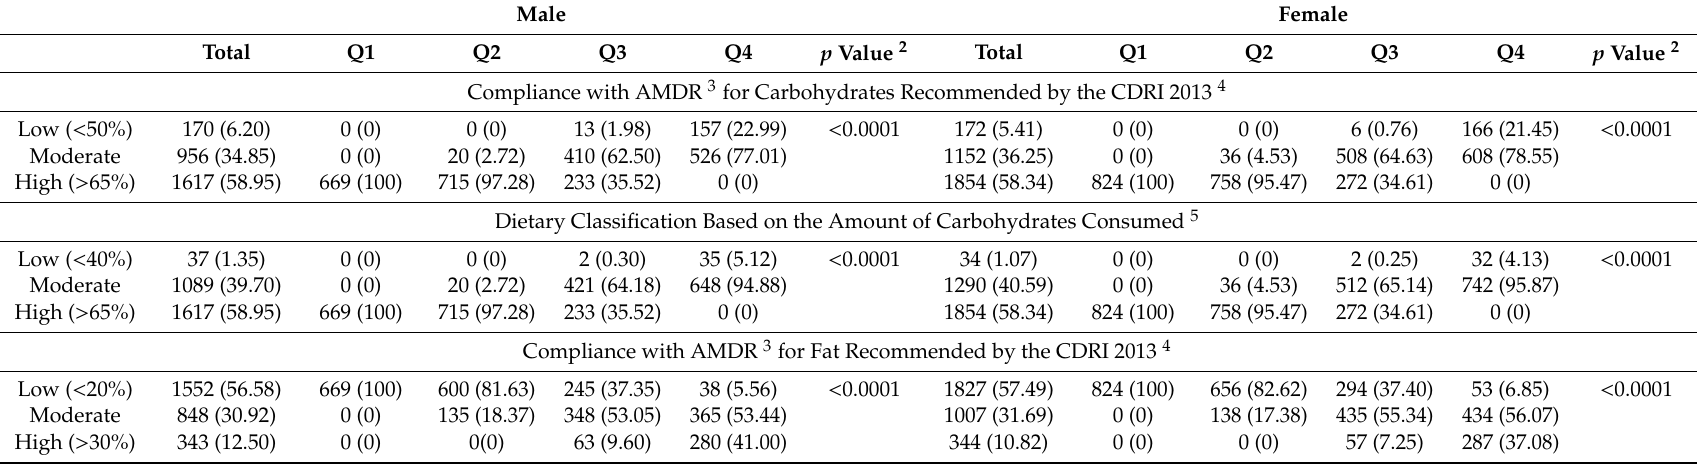
Table 4. Carbohydrate and fat intakes among Chinese adults according to the quartiles (Q) of the low-carbohydrate diet scores, China Health and Nutrition Survey.